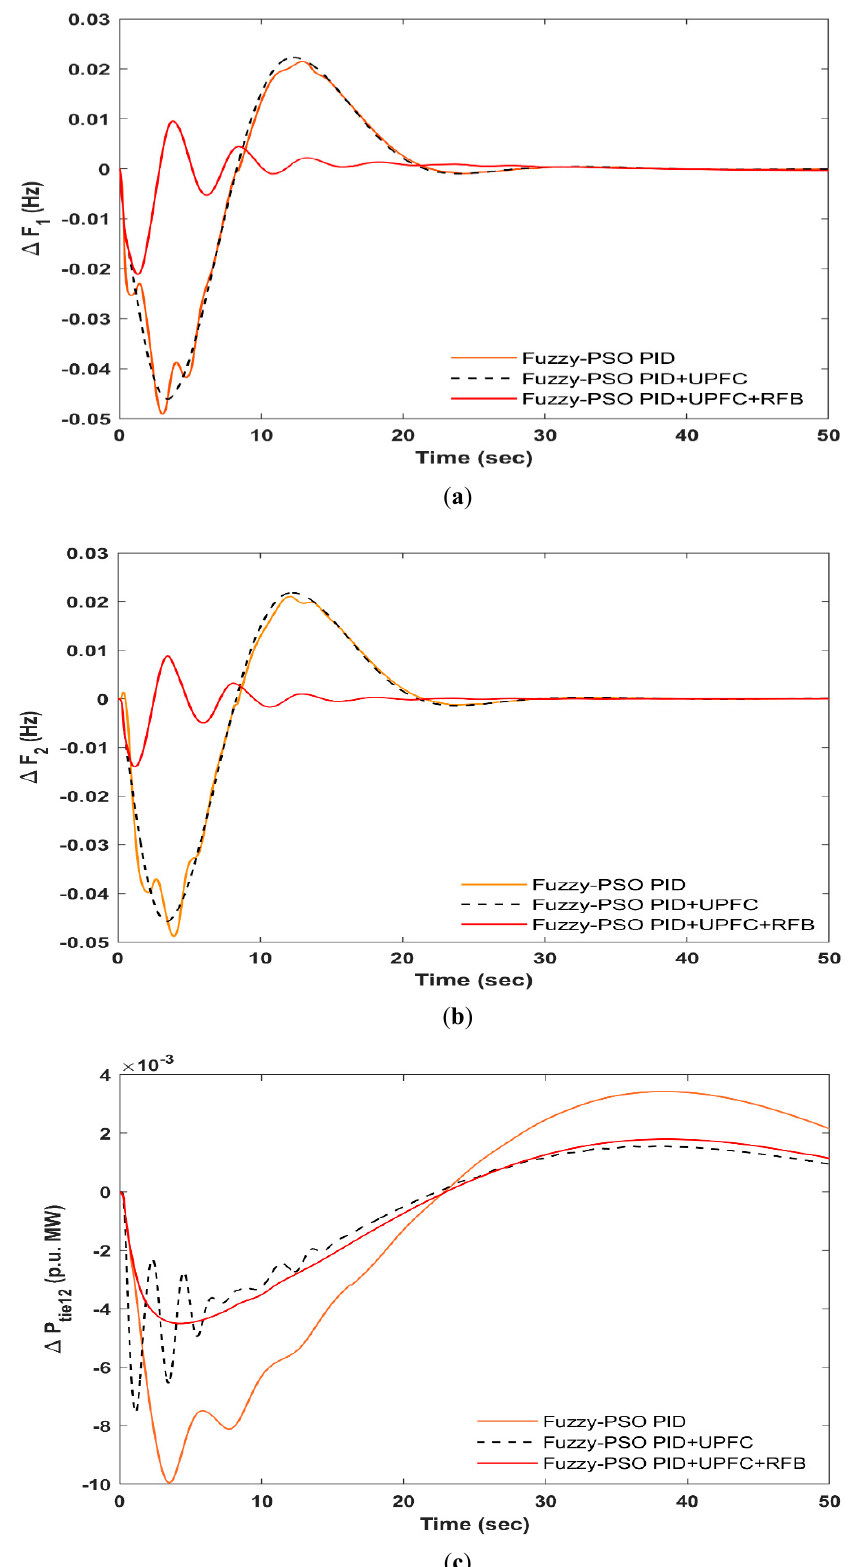
Figure 9. ( a – c ) LFC results for 1% load alteration in region-1.